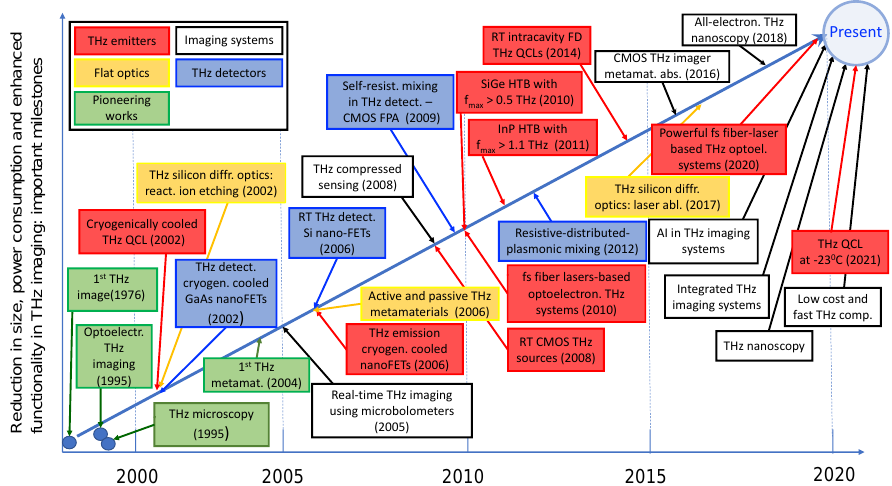
Figure 10. Schematic presentation of important milestones in the evolution of room temperature THz imaging systems within the last two decades. The systems are plotted with respect to the systems size reduction, power consumption, and enhanced functionality. Pioneering works in continuous wave [1] and optoelectronic THz imaging [2], as well as THz microscopy [273], and THz metamaterials [199] are denoted via blue circles and light-green labels. Meanings of other colors are depicted in the top-left corner of the plot. The first THz image recorded using optically-pumped molecular THz laser which is more than 2 meters long and uses of about 7 kW of electrical power, while state-of-art modern electronic sources, e.g., CMOS emitters are compact, in cm scale, and require only up to 1 W of power. No cryogenic cooling is needed for their operation. Invention